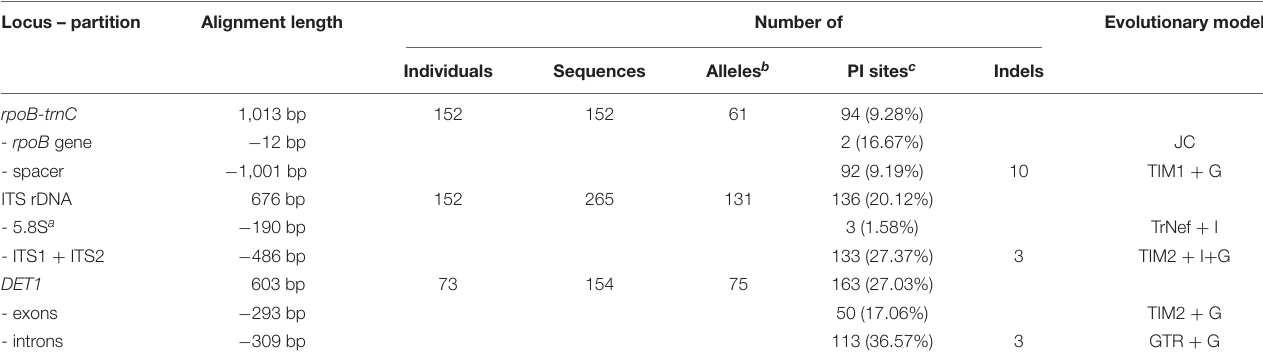
TABLE 3 | Characteristics of the nucleotide alignments used in the present